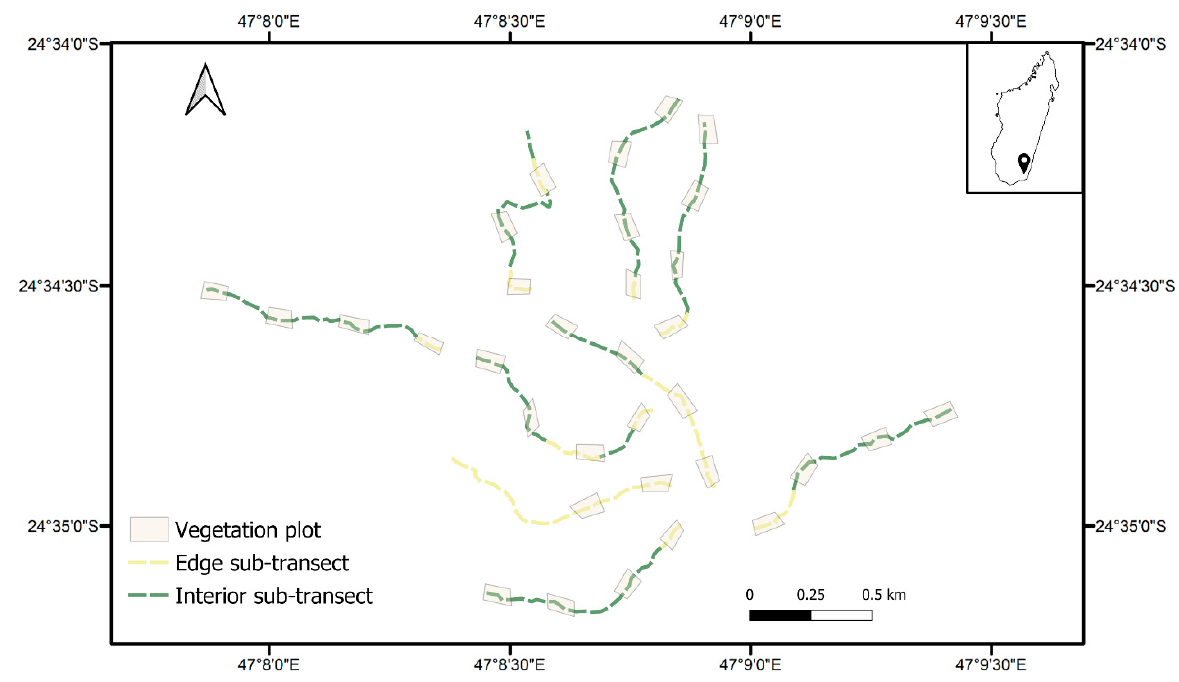
Figure 1. Location of the Ampasy valley in relation to Madagascar. The map indicates the location of the nine transects. used for the lemur surveys and the 33 plots used for the collection of vegetation vegetation data.